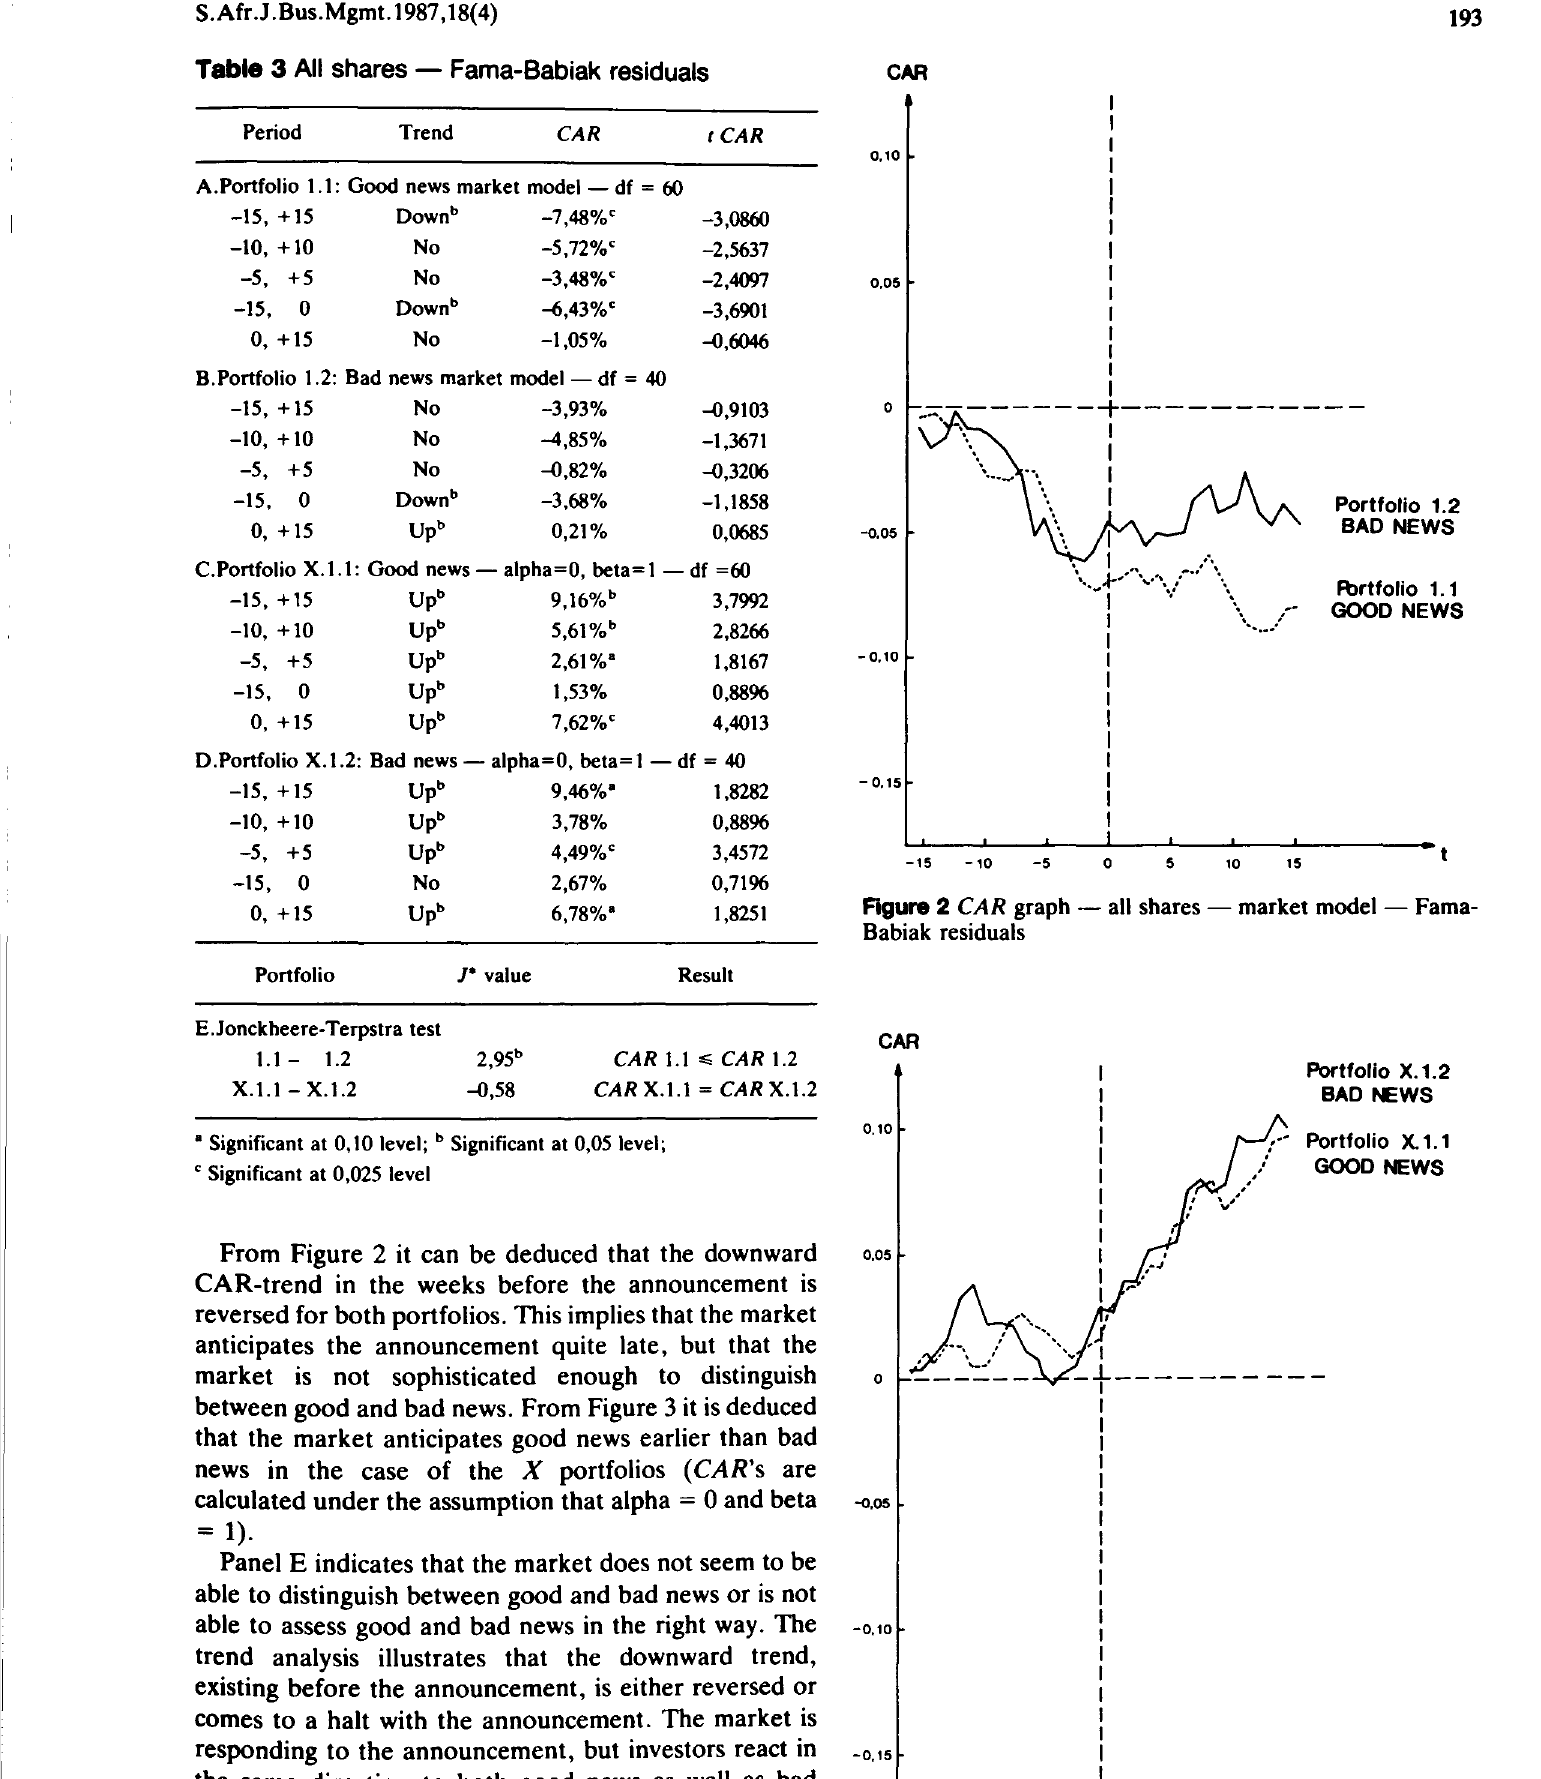
Figure 3 CAR graph - all shares - alpha = 0, beta = 1 - Fama-Babiak